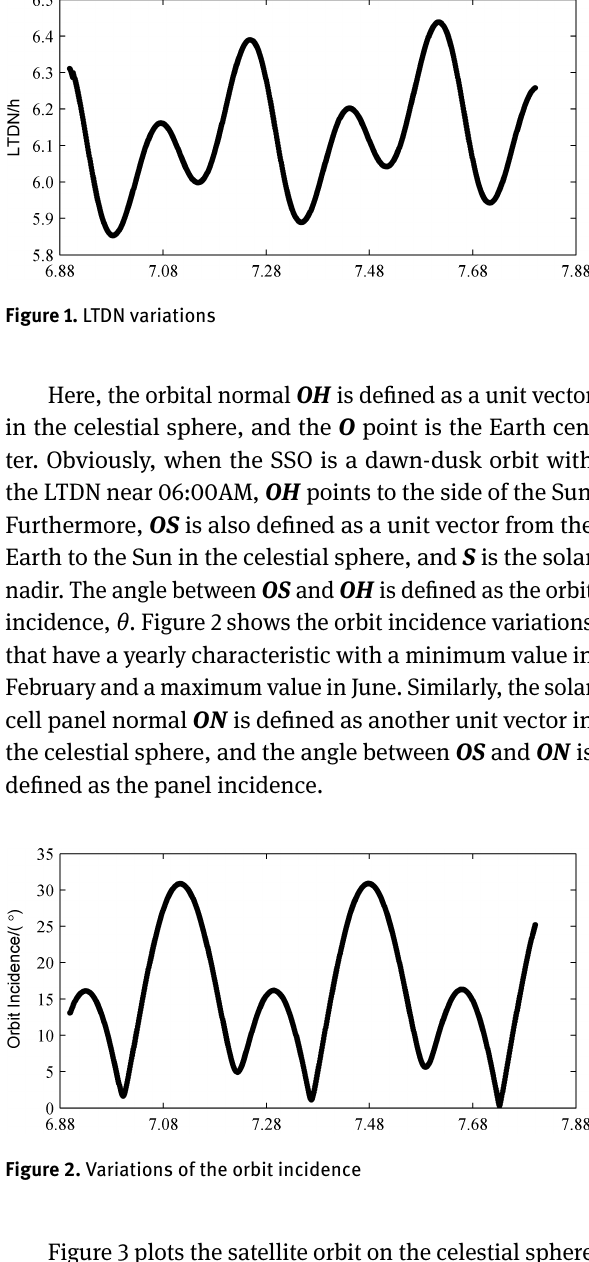
Figure 3 plots the satellite orbit on the celestial